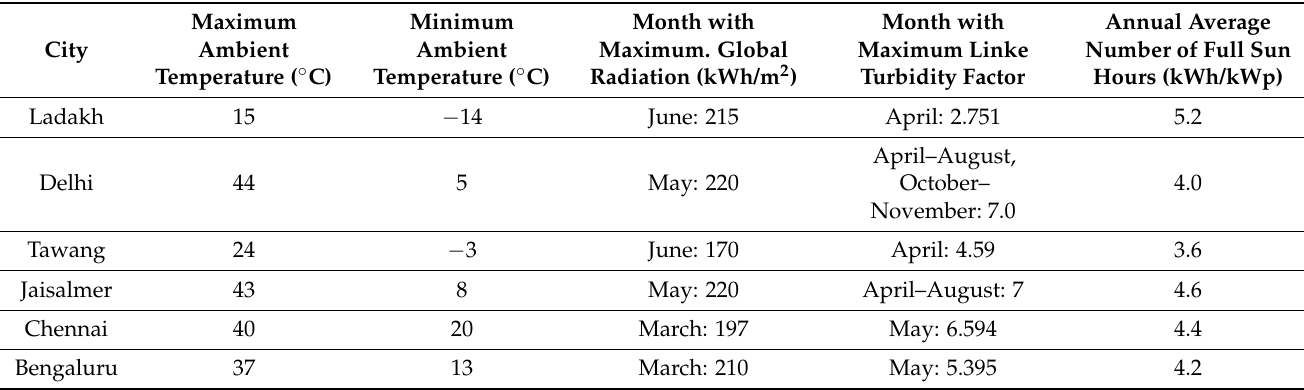
Table 3. Weather parameters of the selected cities